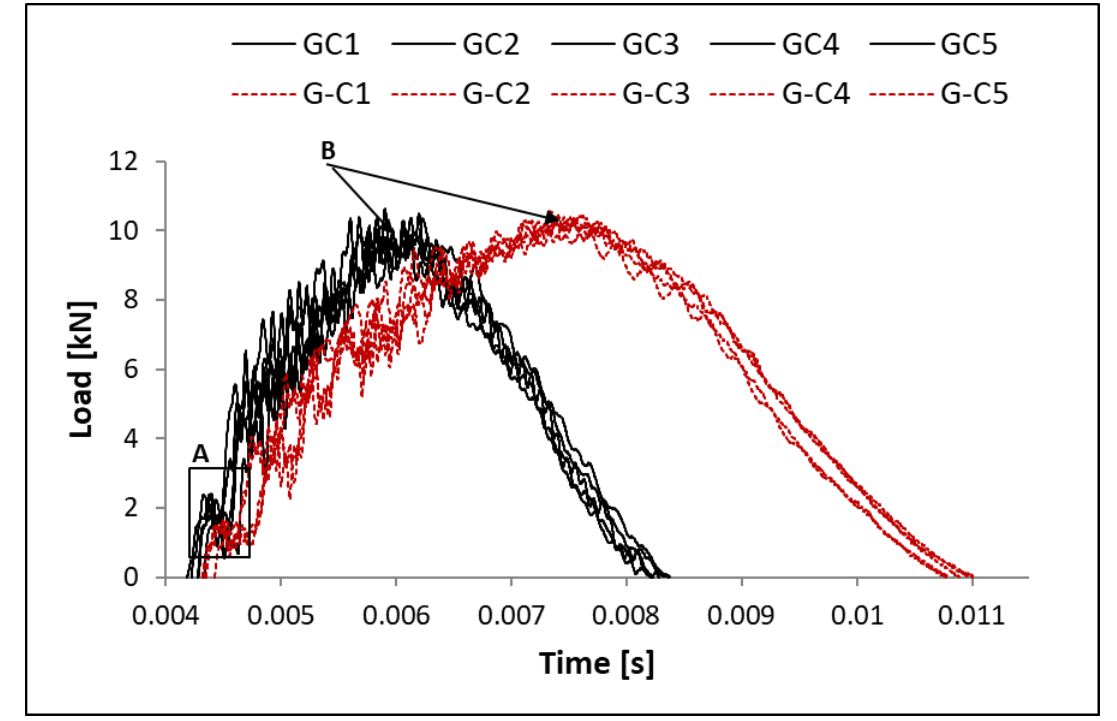
Figure 2. Impact load – time curves of experimental curves of ten hybrid composite tested samples.